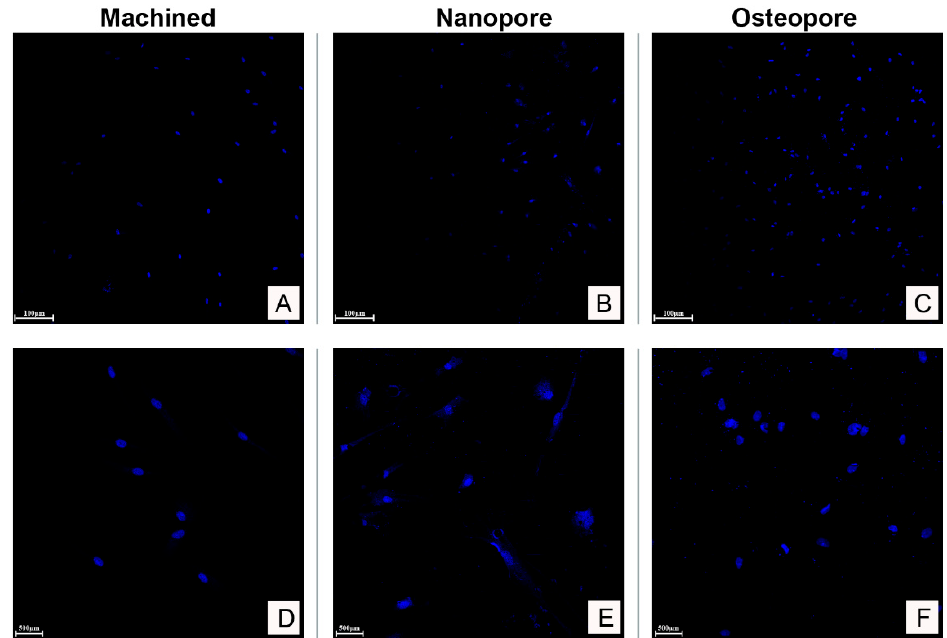
Figure 4. Primary osteoblasts cultured on tested surfaces for 2 days. Cells were fixed in 4.0% paraformaldehyde and nuclei were stained with DAPI (blue). Images were taken by multiphoton microscopy at the magnification of 7 × ( A – C ) (Scale bar: 100 µ m) and 40 × ( D – F ) (Scale bar: 500 µ m).